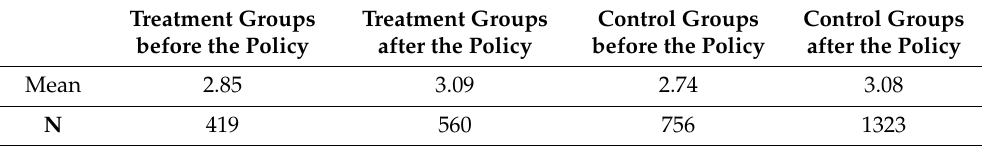
Table 2. Comparison of carbon emission between treatment groups and control